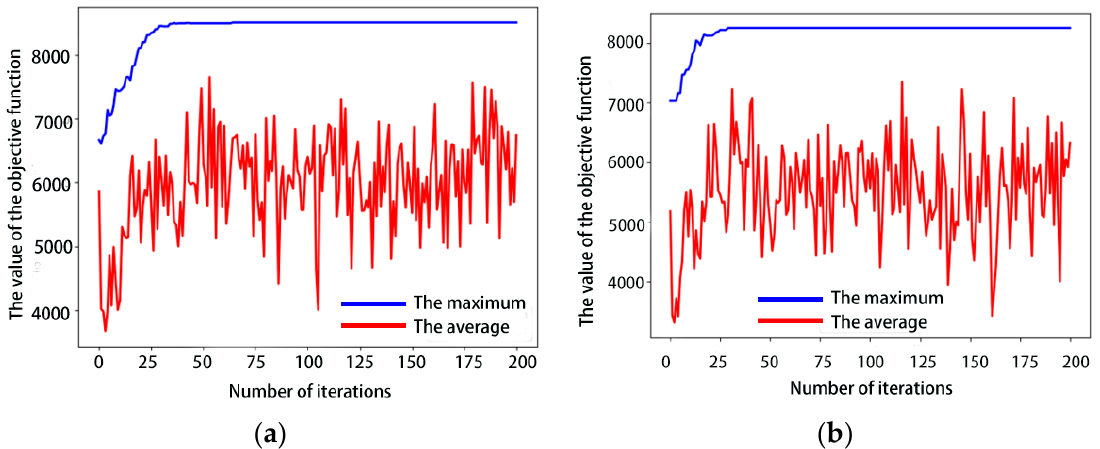
Figure 3. Iteration procedure of the GA with or without the TPS. ( a ) With the TPS, ( b ) Without the TPS ( 𝐸 (cid:3035) = 1.5 ).